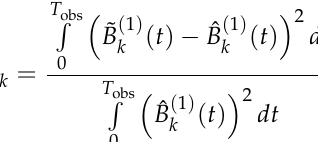
Figure 7. NMSE γ k of each experiment computed from the TV mean Doppler shift ˜ B model fed with IMU data as inputs and the measured TV mean Doppler shift ˆ B